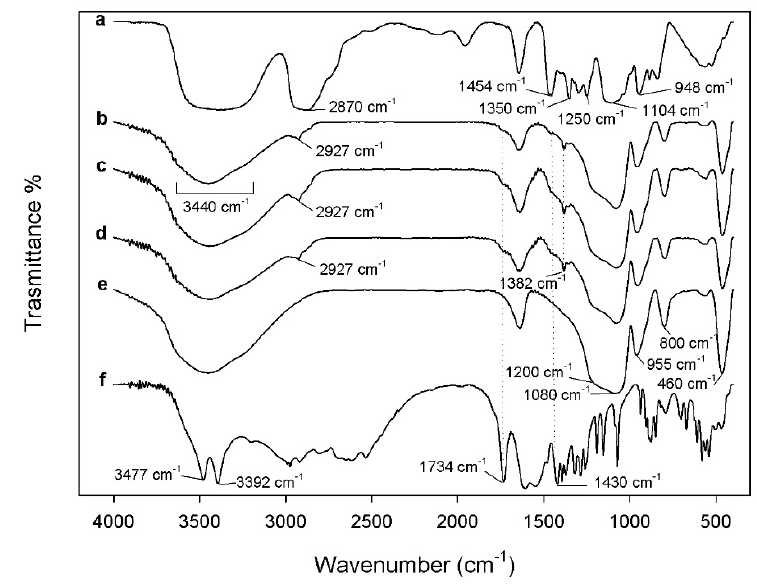
Figure 2. Representative FTIR spectra of ( a ) pure PEG; ( b ) SiO 2 /PEG 12 wt%/ Fe(II)C 5 wt% ; ( c )SiO 2 /PEG 12 wt%/ Fe(II)C 10 wt% ; ( d ) SiO 2 /PEG 12 wt% /Fe(II)C 15 wt% ; ( e ) pure SiO 2 ; ( f ) pure Fe(II)C.